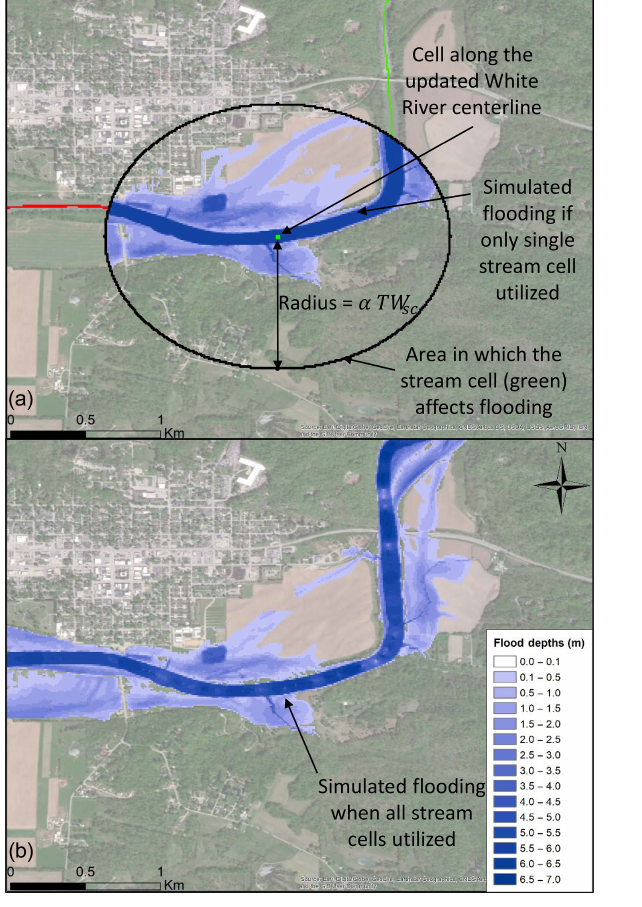
Figure 2. Panel (a) shows flood depths of surrounding terrain from a single stream cell. Notice the area of influence (cells within radius = α TW sc ) appears elliptical due to projection of the map. Panel (b) shows flood depths along the river when the depths from all stream cells are utilized. Notice that some areas shown as flooded in (a) are not flooded in (b) due to the influence of stream cells with lower depth calculations. Sources of the back- ground imagery include ESRI, DigitalGlobe, Earthstar Geograph- ics, CNES/Airbus DS, GeoEye, USDA FSA, USGS, Getmapping, Aerogrid, IGN, IGP, and the GIS user